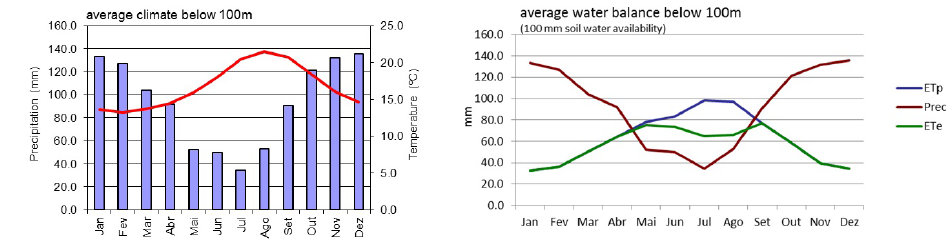
Figure 2. Normal climate and a typical sequential water balance at the littoral of the Azores